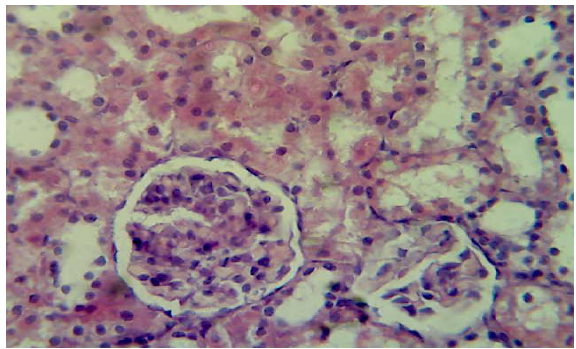
Figure, 12. In section of histopathology in the kidney of rat (G1 group) for 65 day: showed normal structure (H. & E.stain 400X).